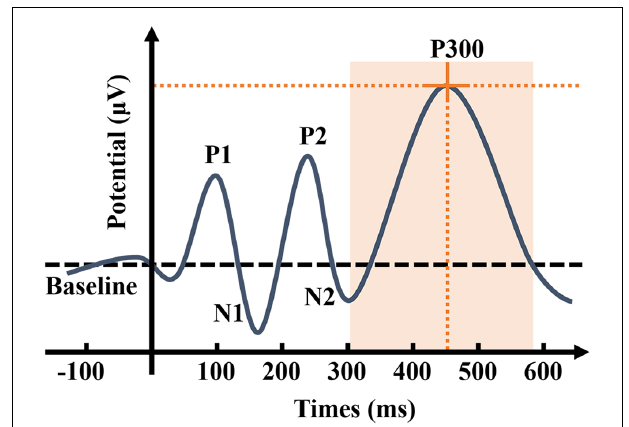
FIGURE 2 | Schematic representation of auditory event-related potential (ERP). P300 is the ERP component triggered by the brain in response to low-probability stimuli, causing a maximum positive wave approximately 300 ms after the stimuli. As the most widely used component in ERP, P300 has two characteristics: amplitude and latency. The P300 amplitude refers to the maximum value that ERP achieves in the time window of 300–500 ms, while peak latency refers to the delay time between the occurrence of the stimuli to the detection of the maximum potential value (Johnson, 1993). P300 amplitude is considered to reflect the attentional resource allocation (Donchin and Coles, 1988; Kok, 2001). P300 latency is considered to reflect the processing speed or efficiency in the process of detecting and evaluating the stimulus (Kutas et al., 1977), and individual differences for P300 latency are correlated with mental function speed, such that shorter latencies are related to superior cognitive performance (Polich, 2007). P300 is affected by numerous factors, such as the concentration of the subject’s attention, the difficulty of the task, the probability of deviation from the stimulus, and the time interval between the two